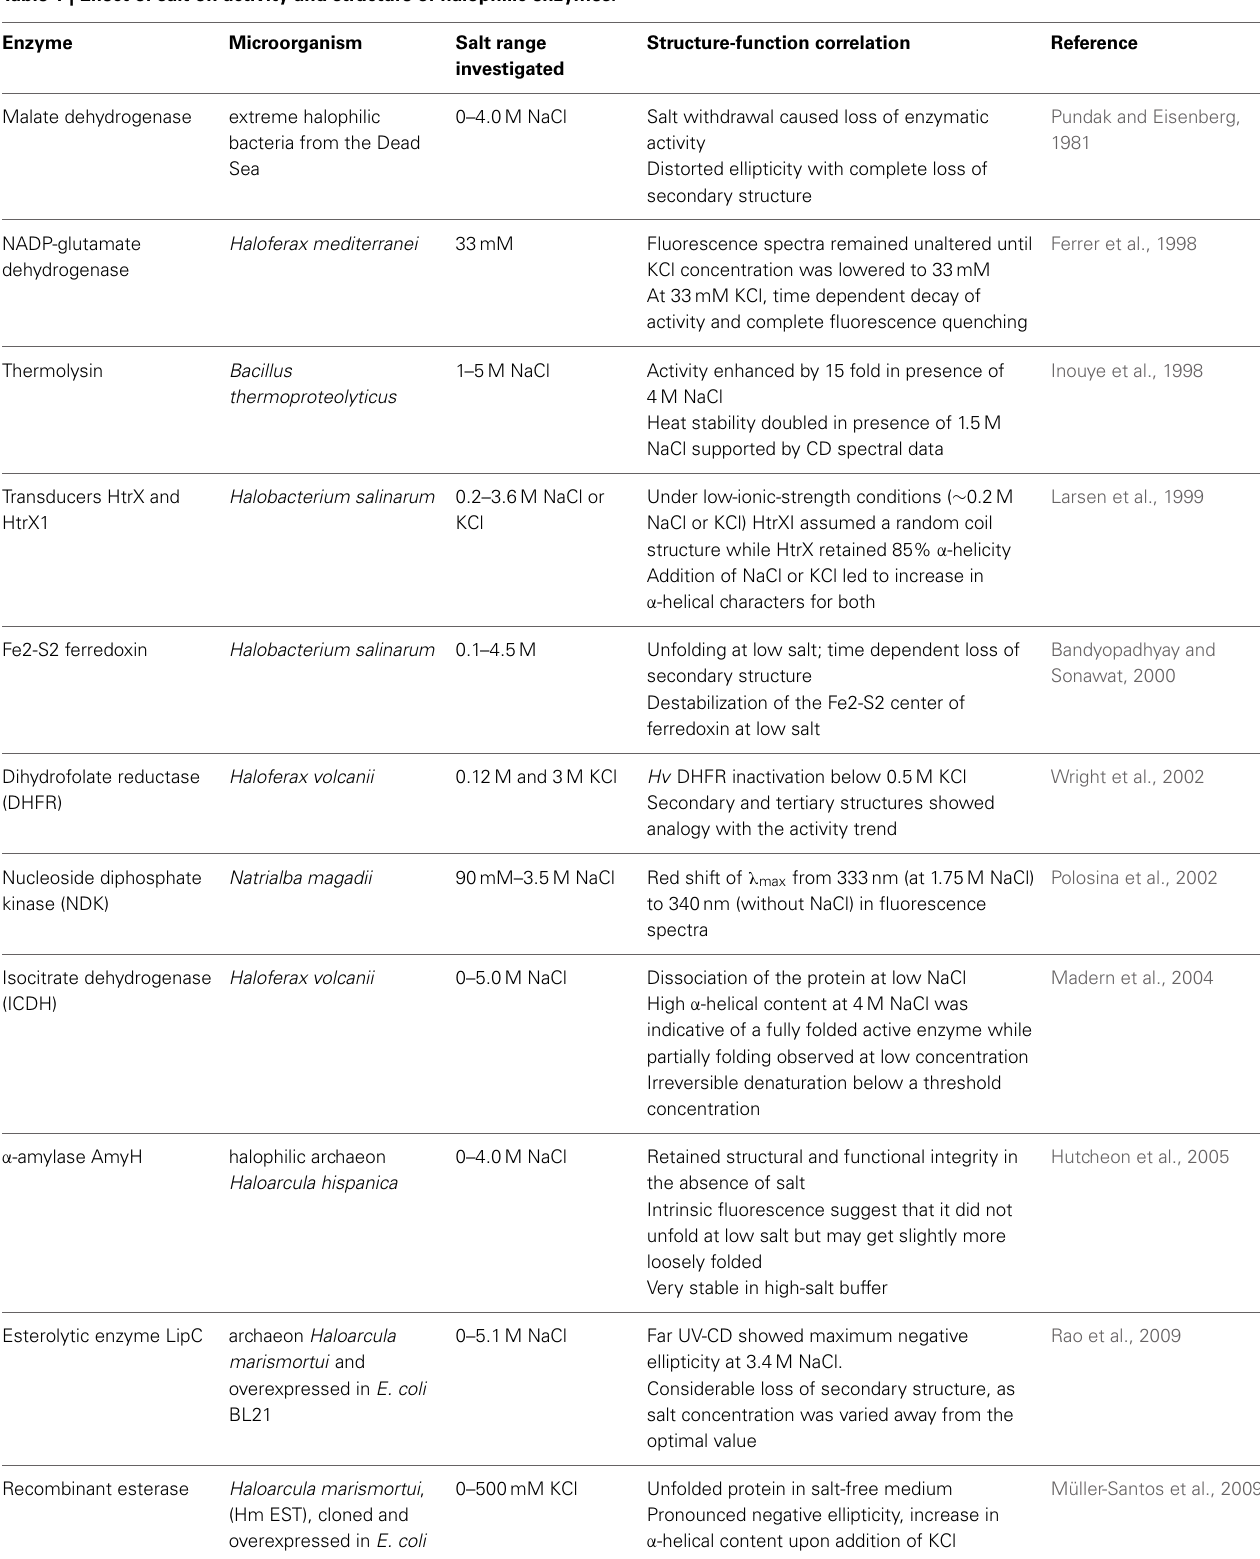
Table 1 | Effect of salt on activity and structure of halophilic